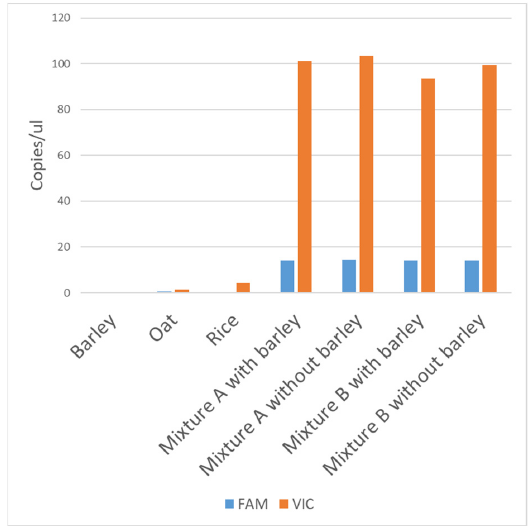
Figure 3. Copies/µL of FAM and of VIC targets. A total of 20 ng of barley, oat and rice DNA was amplified in dPCR. Mixture A was obtained by mixing 15 ng of hulled wheat DNA plus 4 ng of hulless wheat, with or without 1 ng of barley DNA. Mixture B was obtained by mixing 14 ng of hulled wheat DNA plus 4 ng of hulless wheat, with or without 2 ng of barley DNA.